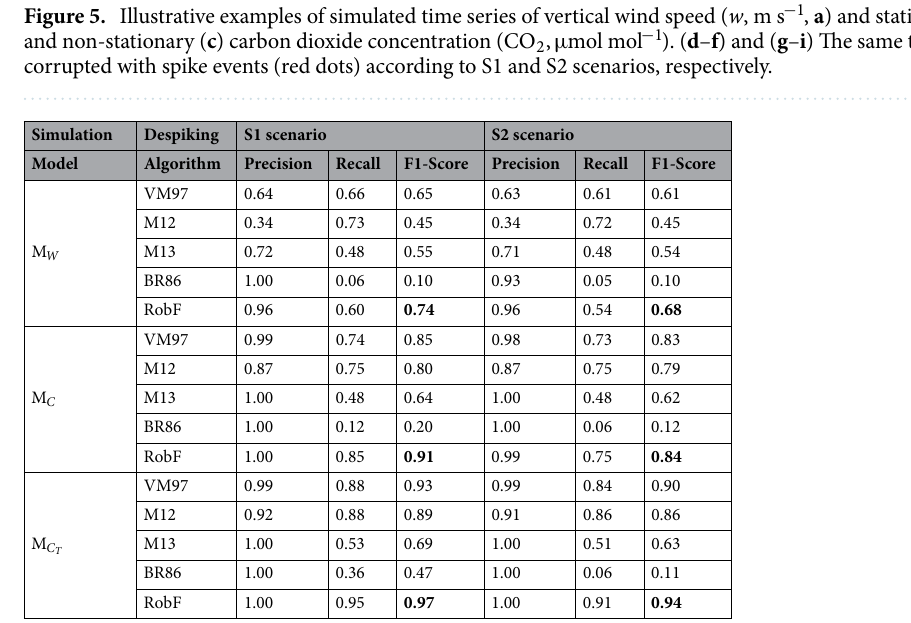
Table 3. Performance evaluation metrics of despiking methods. The highest F-Score metric (i.e., best perfomance) for each scenario is shown in